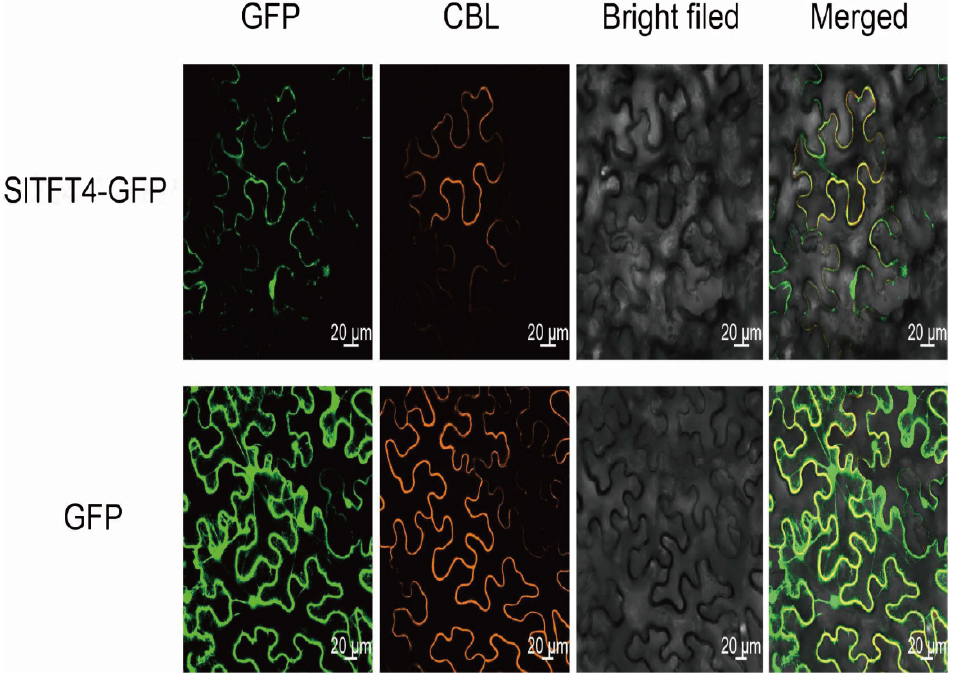
Figure 11. Subcellular localization of SlTFT4. The name of the constructed vector is shown on the left. Images under bright field and fluorescence are displayed. The scale bar is 20 μ m .